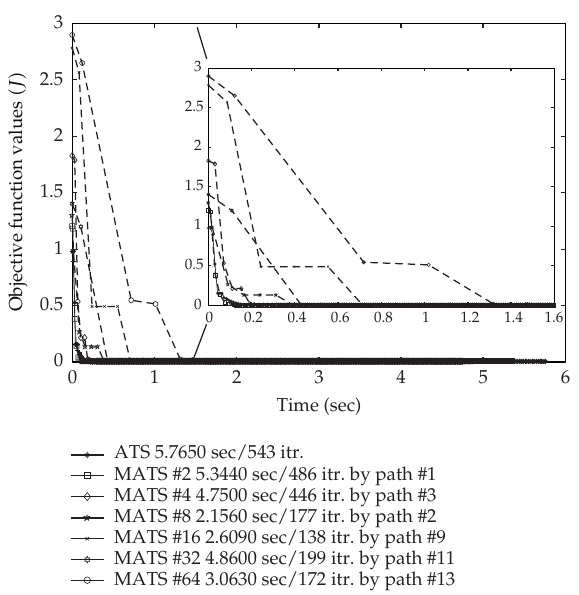
Figure 10: Convergence curves (cid:4) BF problem (cid:5) .